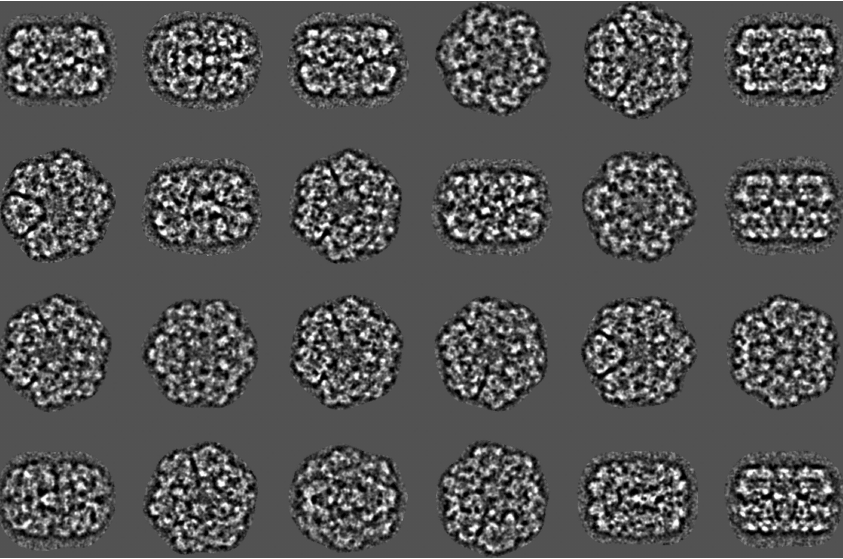
Figure 10 Effect of ABC optimization. After ABC alignment of the full data set, all images are rotated and shifted to a common origin as dictated by the Euler orientations of the class averages. A new MSA classification thus yields a better class average since more molecular images now have a common three-dimensional orientation. Shown here are class averages at an intermediate level of the refinement procedures at a coarsening level of 2 (Nyquist frequency 1/4.4 A˚